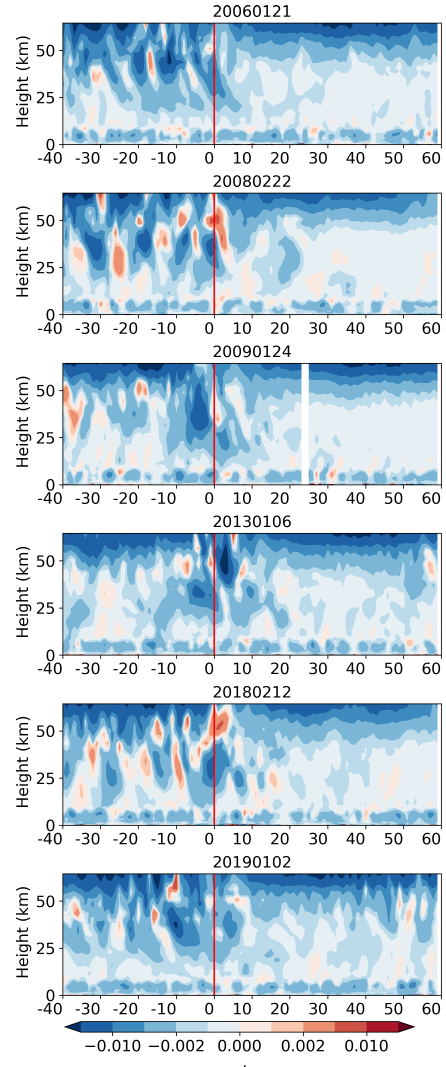
Figure 10. Similar to Fig. 8 but for the of the vertical component of the residual circulation, w ∗ , for zonal